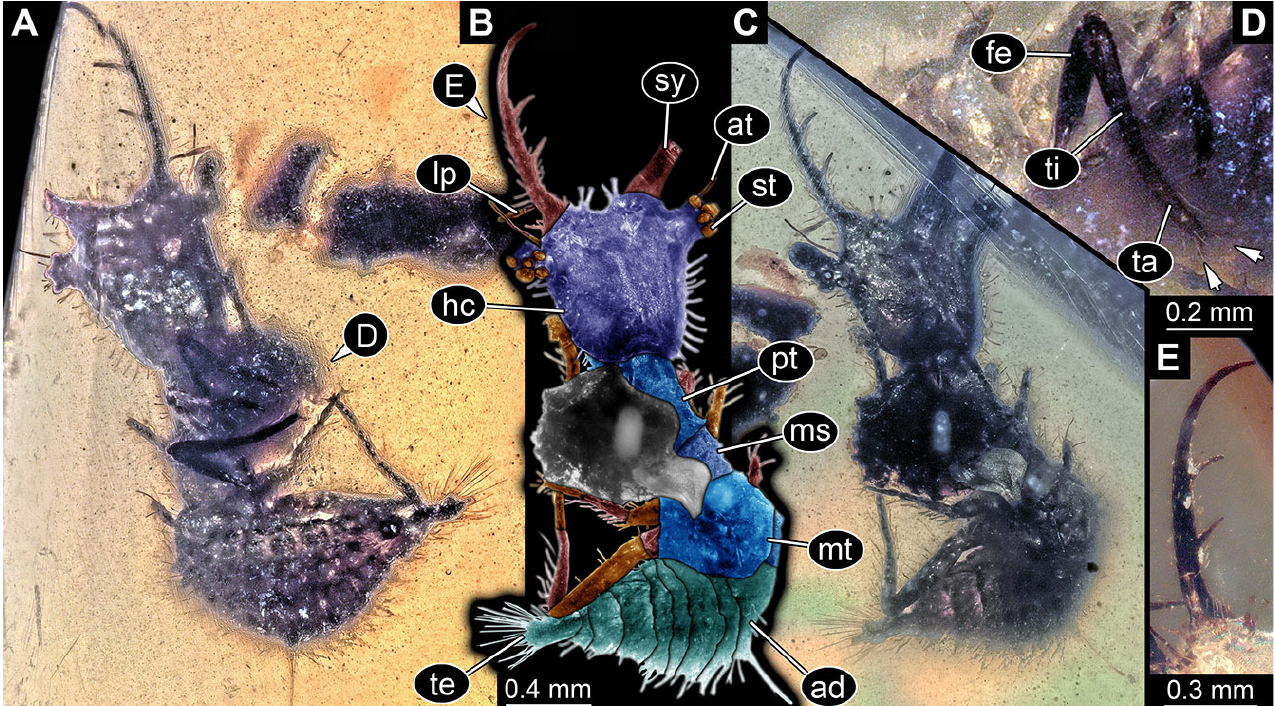
Figure 19. Fossil owllion larva, specimen 3232 (PED 0087), Cretaceous Kachin amber, Myanmar. ( A ) Overview, oblique ventral. ( B ) Color-marked version of ( C ). ( C ) Overview, oblique dorsal. ( D ) Close-up on locomotory appendage with claws (arrows). ( E ) Close-up on stylet. Abbreviations: ad = abdomen; at = antenna; fe = femur; hc = head capsule; lp = labial palp; ms = mesothorax; mt = metathorax; pt = prothorax; st = stemmata; sy = stylet; ta = tarsus; te = trunk end; ti = tibia.